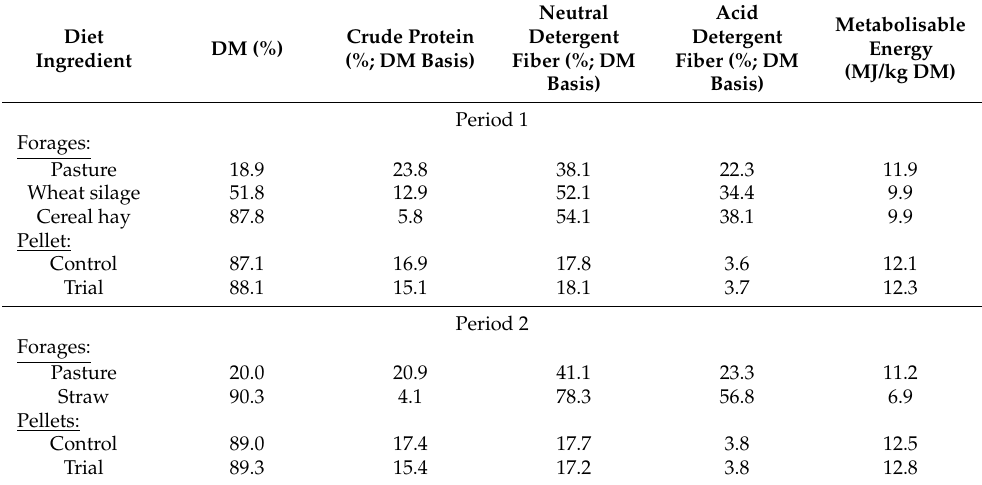
Table 2. Nutritive value for forages and pellets.